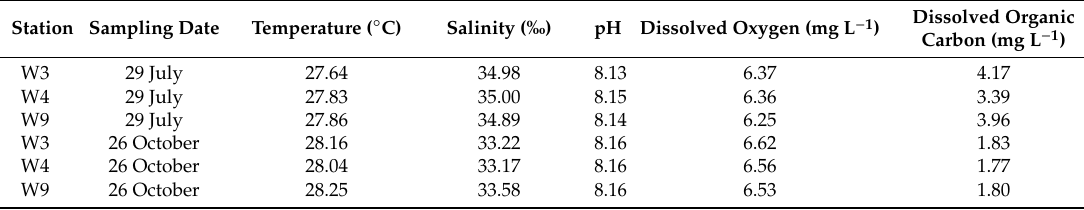
Table 1. Environmental parameters sampled in 2014 in the northern South China